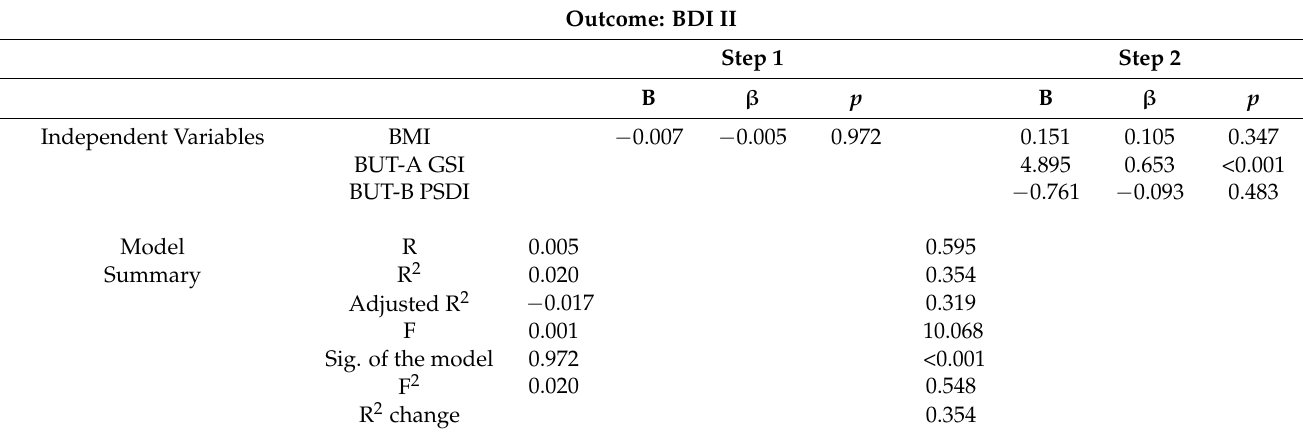
Table 7. Fifth hierarchical regression models including two steps, with BMI as predictor in first step; BMI, BUT-A GSI, and BUT-B PSDI as predictors of BDI II in second step. Outcome: BDI